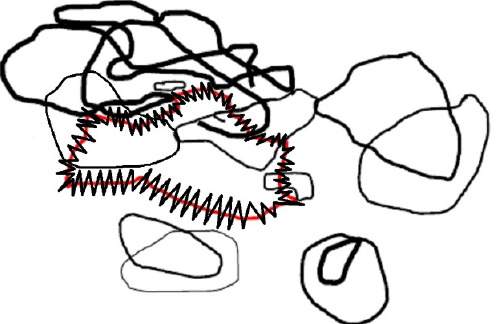
Figure 6 . One more open string contribution is added as a wavy closed curve in the cyclic chain. All curves have no